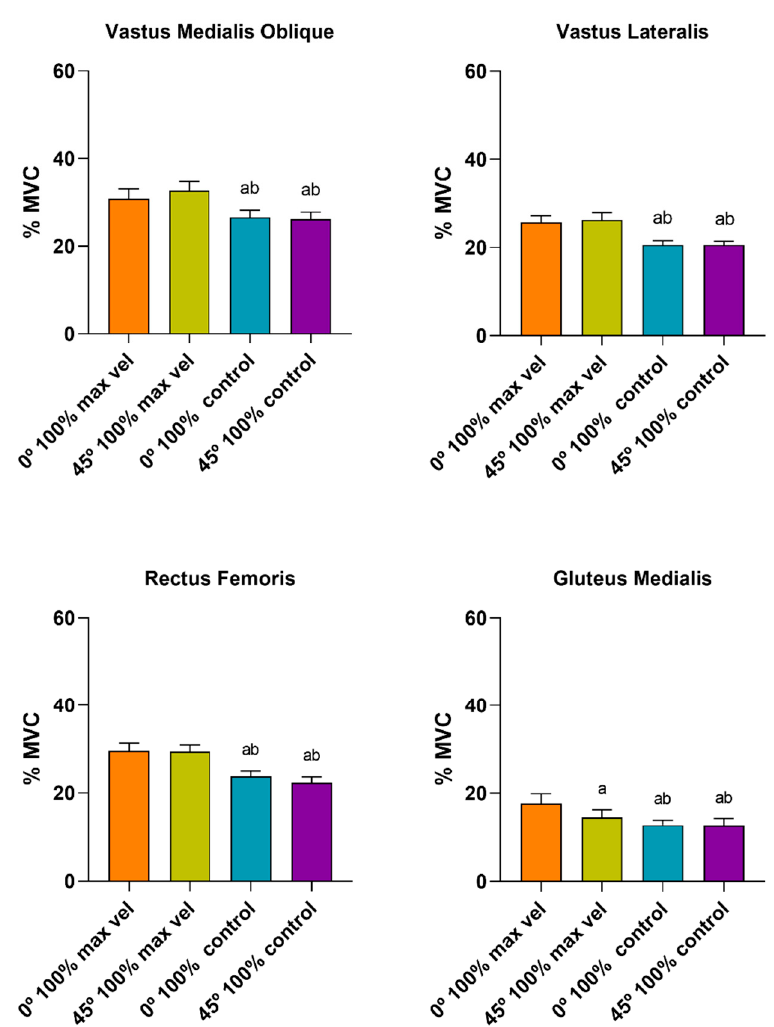
Figure 2. Comparison of eccentric muscle activation for each muscle between 0° 100% and 45° 100%, performed at the maximal intended and controlled velocities ( ᵃ difference from 0° 100% max. vel., ᵇ difference from 45° 100% max. vel.; p < 0.05).